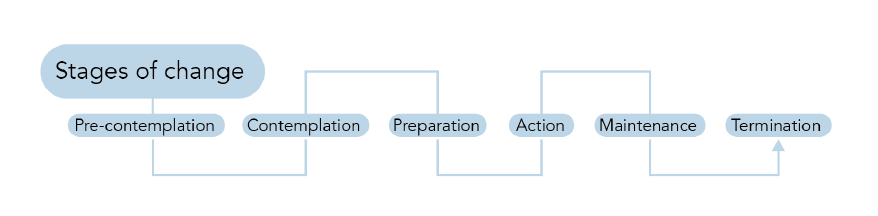
Figure 1. The Transtheoretical model of behaviour change.